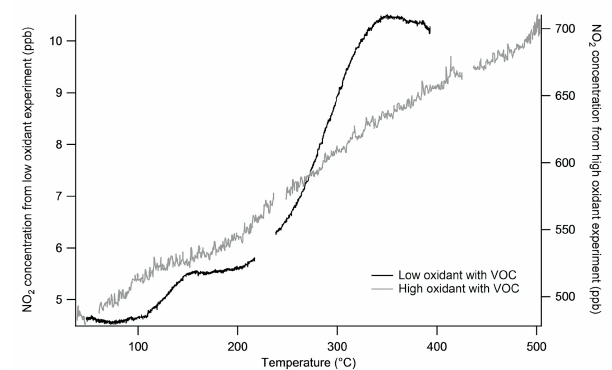
Figure 5. Comparison of two experiments under different initial NO 2 conditions to change the total N 2 O 5 concentration. Both ex- periments contain 300ppb (cid:49) -carene. The “high-oxidant” experi- ment was performed with 650ppb O 3 and 400ppb NO 2 , which yields substantial N 2 O 5 formation. The “low-oxidant” experiment was performed with 335ppb O 3 and ∼ 3ppb NO 2 and reveals the clean separation of PNs and ANs by plateaus. There are no distinct plateaus for PNs and ANs in the high-oxidant experiment because they are washed out by the more gradually temperature-dependent dissociation of N 2 O 5